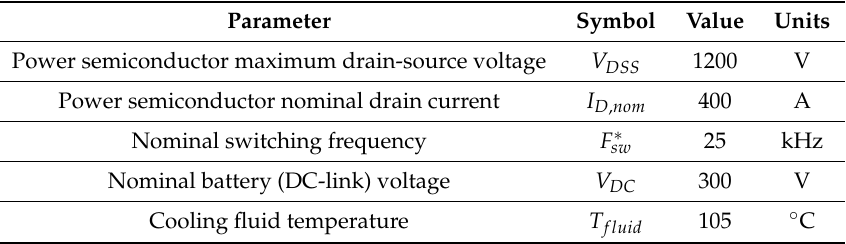
Table 1. Most relevant parameters of the simulated power electronics system.